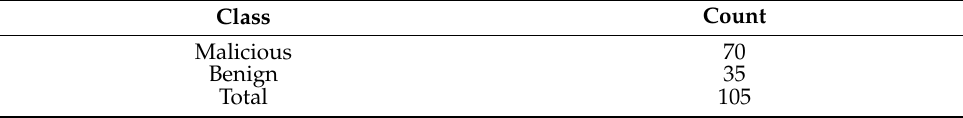
Table 16. Test sample